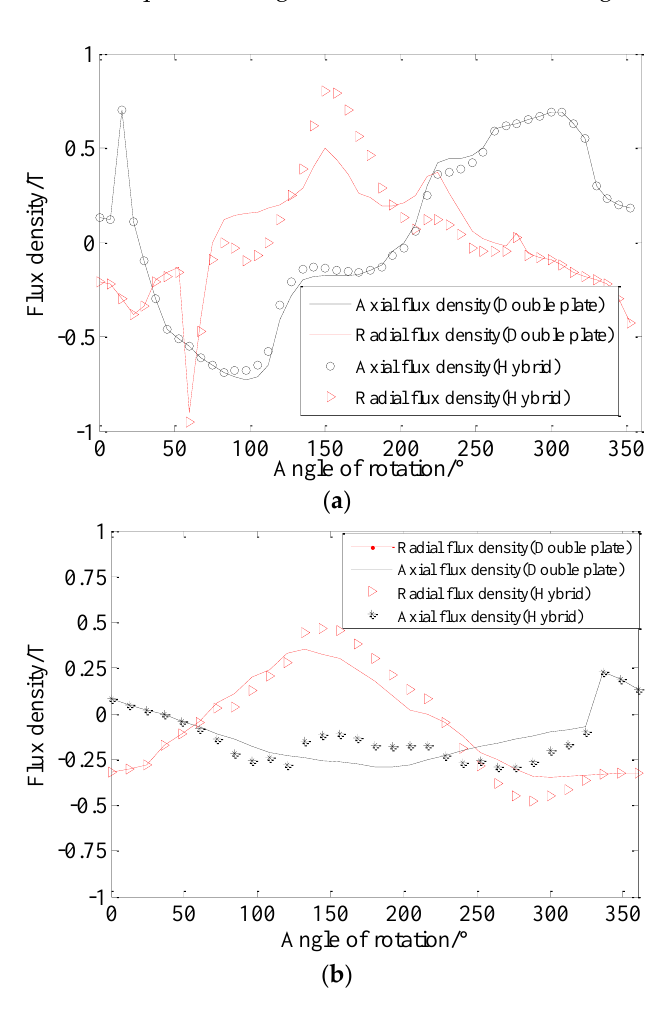
Figure 5. Magnetic flux density distribution at the center of the air gap: ( a ) the radial air gap is 5 mm and the axial air gap is 10 mm; ( b ) the radial air gap is 20 mm and the axial air gap is 15 mm.